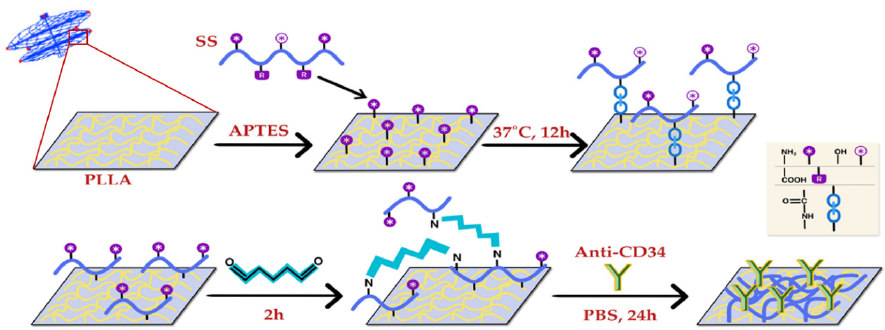
Scheme 1. Schematic diagram of CD34 antibody coating of the fiber membrane